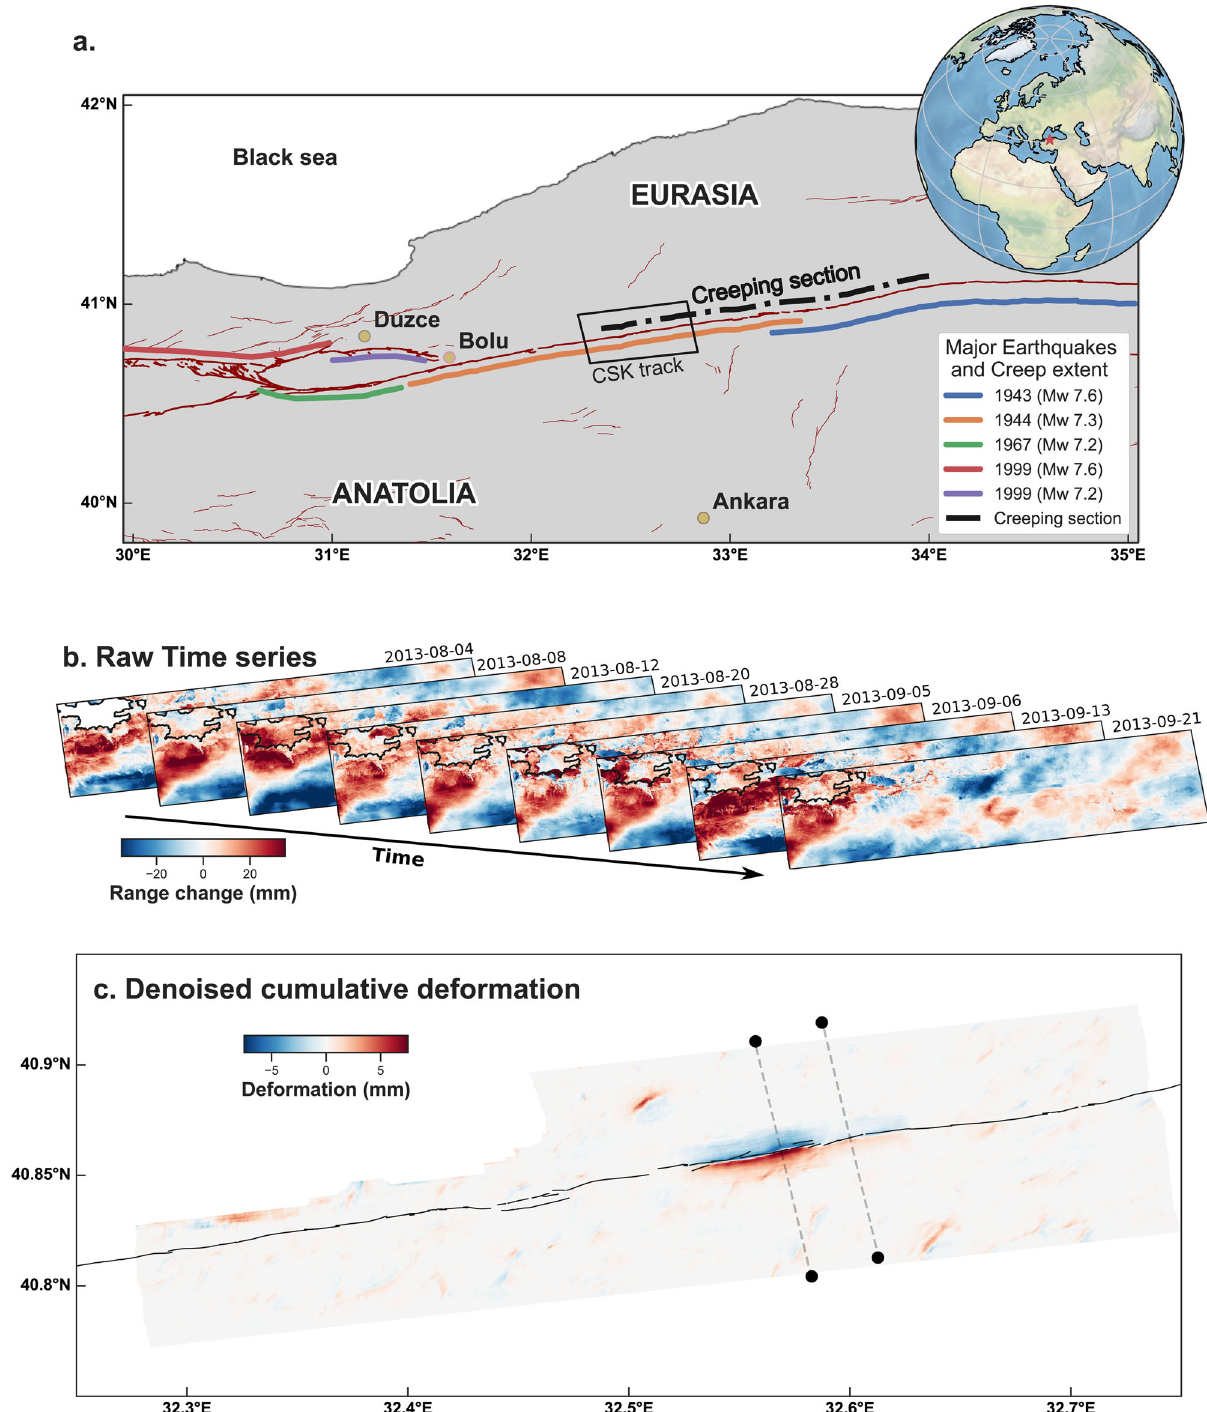
Fig. 3 Application to real data: the North Anatolian Fault 2013 slow earthquake. In order to identify ground deformation signals in the noisy COSMO- SkyMed InSAR time series, we create a deep autoencoder that has an input size equal to the size of each frame of the time series, 200 × 650 pixels, and the same parameters as the autoencoder trained on synthetic data, shown in Fig. 1. Inputs are the InSAR time series and the topography of the same area (not shown). The autoencoder outputs ground deformation (bottom plot). The ground deformation is manifest as an offset across the fault. The deep autoencoder fi nds a strong slip signal of about 1 cm (in LOS) on the fault, in agreement with previous expert analysis of the time series 14 , with no a priori knowledge of the fault ’ s existence. a . Seismic setting of the region of the creeping section of the North Anatolian Fault. Thick red lines are the main faults of the NAF system, separating the Eurasia plate from the Anatolia microplate. Thin red lines are other mapped structures. Colored lines indicate the extent of historical ruptures. b Input raw time series from COSMO-SkyMed data (a subset of the data from Rousset et al., 2016). Color is the apparent range change between the ground and the satellite. c Denoised cumulative deformation as output by the deep autoencoder. The color scale shows ground deformation in the direction of the LOS. Dark lines are the surface trace of the NAF, shown here for reference. Thin dashed lines indicate the cross-sections shown in Fig.